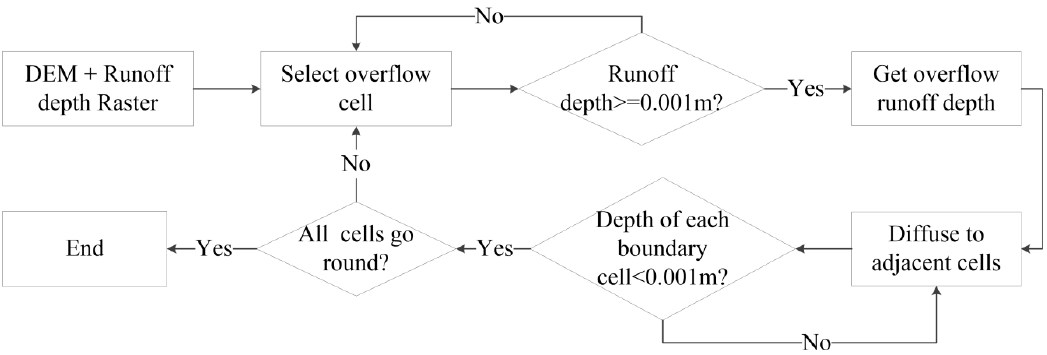
Figure 3. The process of inundation diffusion.